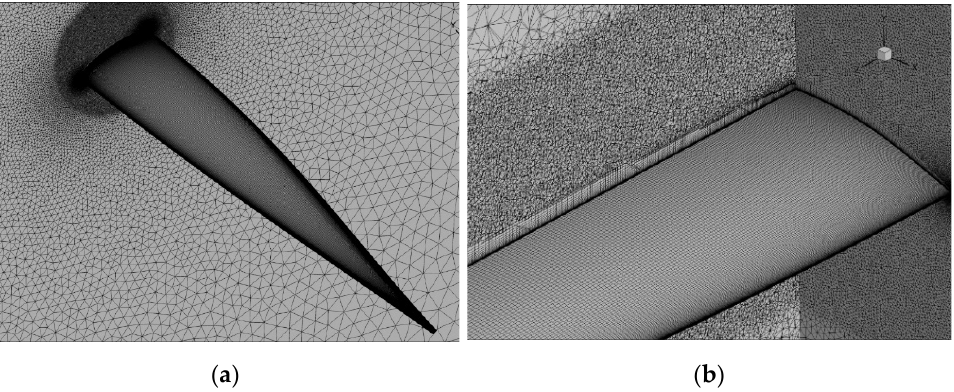
Figure 3. Surface grid on the wing and the symmetry plane. Prismatic layers and the density region on the symmetry plane can be seen ( a ). Cross-section of volume grid ( b ) depicts transition between prismatic layers and outer polyhedral grid. It can be seen that the transition is gradually modeled.